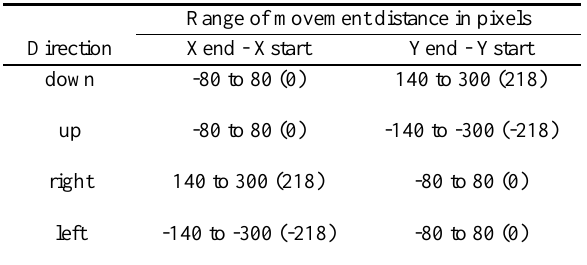
Table 2. Ranges of differences between first and last POR (x- and y-PORs).